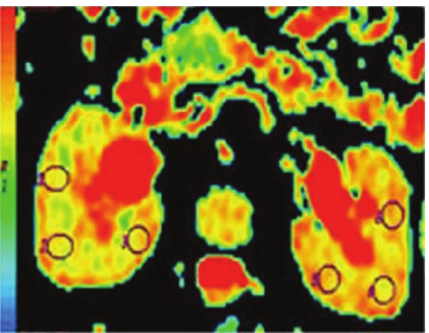
Figure 1: Axial ADC map calculated from echoplanar DWI of hydronephrotic kidneys with a high b value. The yellow-green coloration was observed significantly in the right hydronephrotic kidneytobecompatiblewithlowerADCvalues.TheROIsareplaced in three locations: an anterior portion, an intermediate site, and a posterior